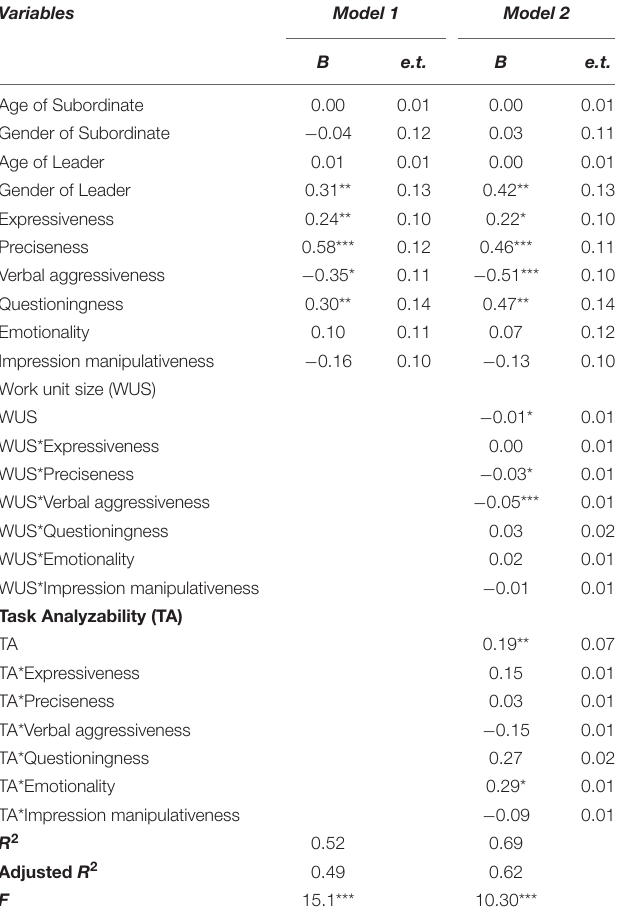
TABLE 3 | The Moderating Effect of Contextual Variables on the Relationship between Leader’s Communication Style and LMX.